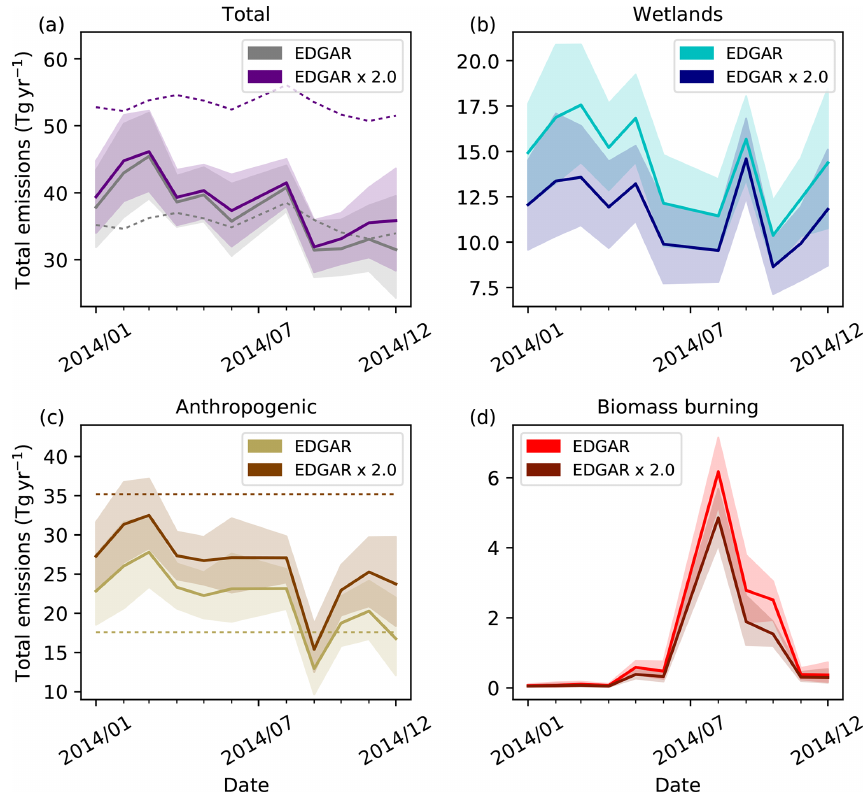
Figure A7. Brazil’s CH 4 emissions in a sensitivity inversion using perturbed a priori anthropogenic emissions. All other components were held at the original configuration. Anthropogenic emissions for all of South America were doubled from EDGAR. (a) Total, (b) wetland, (c) anthropogenic and (d) biomass burning emissions. Prior emissions are only shown in (a, c) as they only vary for these components in this